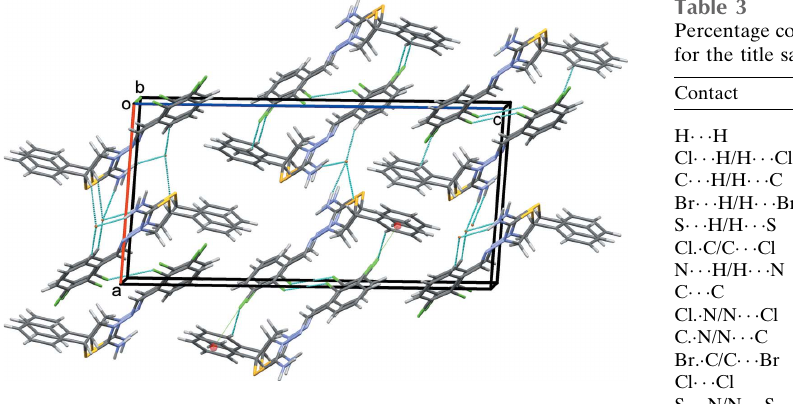
Figure 4 Overall packing of the title salt viewed along the b axis. Only the major disorder component is shown.